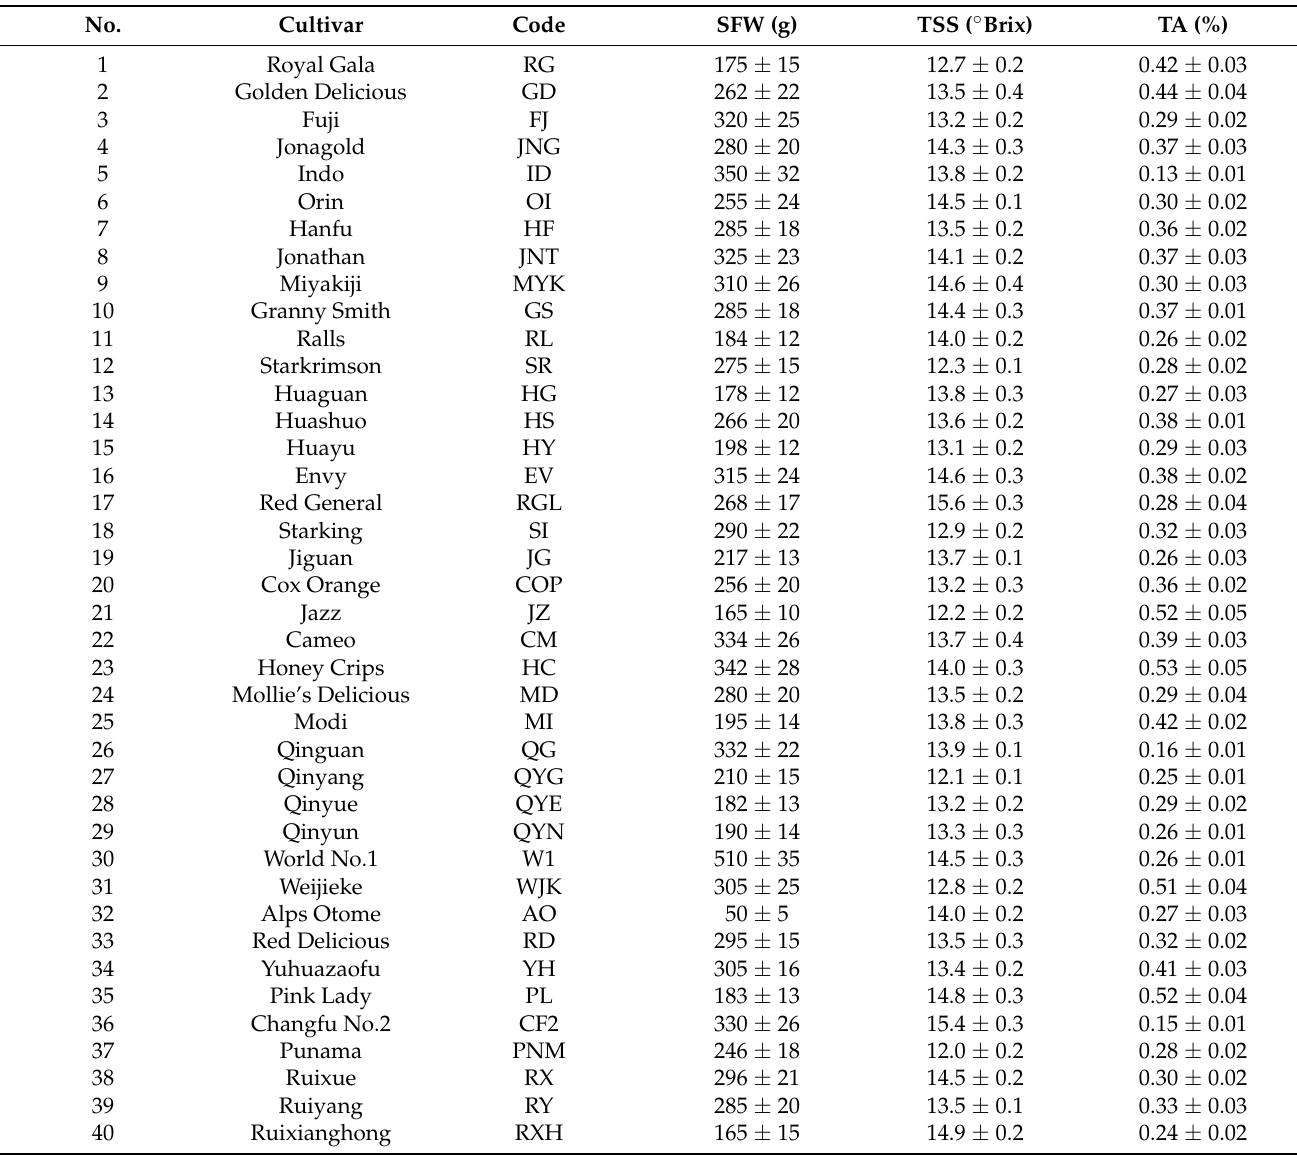
Table 1. Apple cultivars used in this study and some basic fruit quality